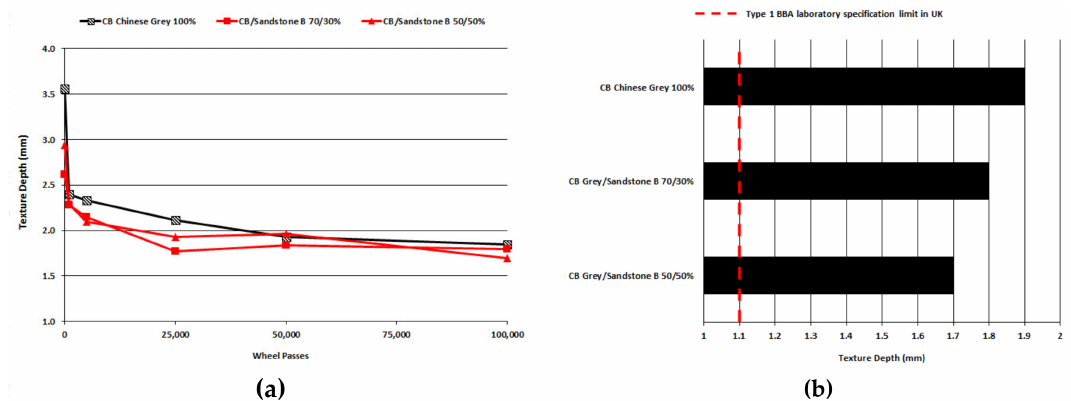
Figure 8. ( a ) Texture depth development up to 100,000 wheel-passes; ( b ) texture depth ranking after 100,000 wheel-passes (Ulster University data).